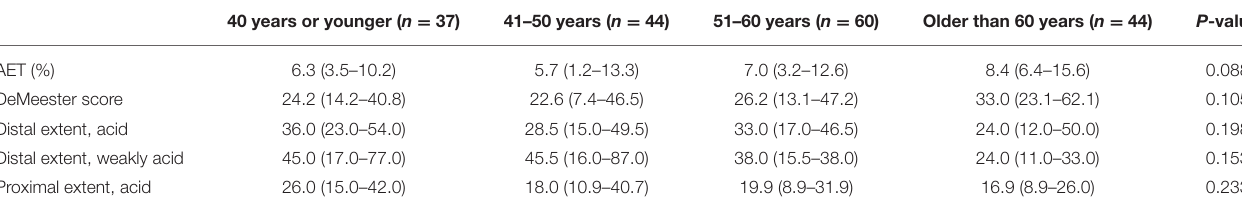
TABLE 3 | Reflux characteristics according to